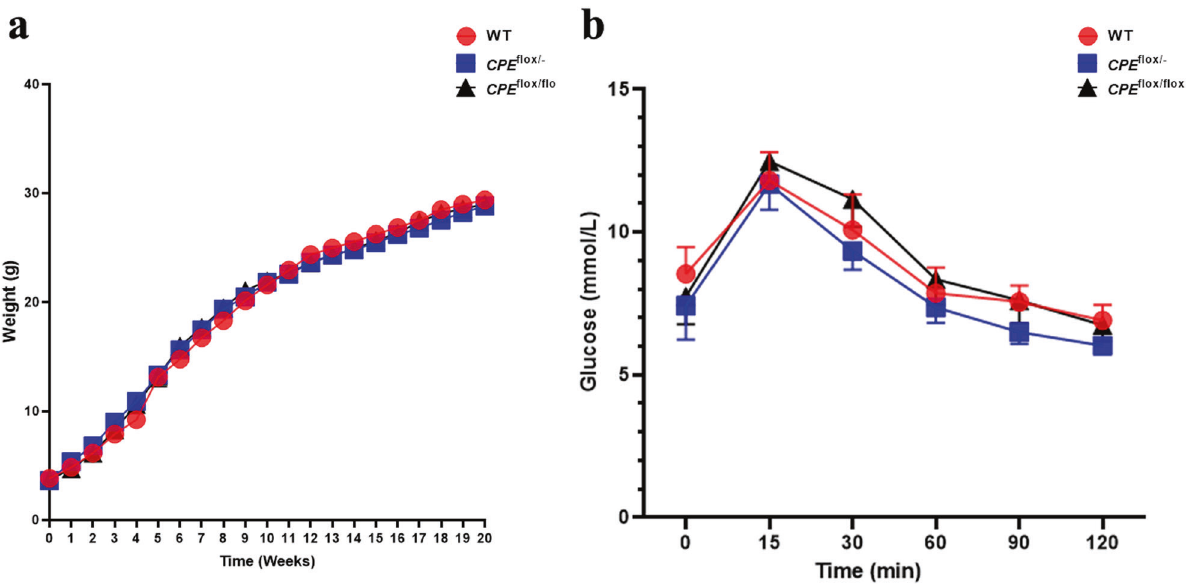
Fig. 1 Body weight and glucose levels in CPE fl ox/ fl ox mice. a Weights of WT, CPE fl ox/- , and CPE fl ox/ fl ox mice were recorded from 1 – 20 weeks of age. b Fasting and metabolism levels of glucose in plasma of WT, CPE fl ox/ − , and CPE fl ox/ fl ox mice. n = 10 from each